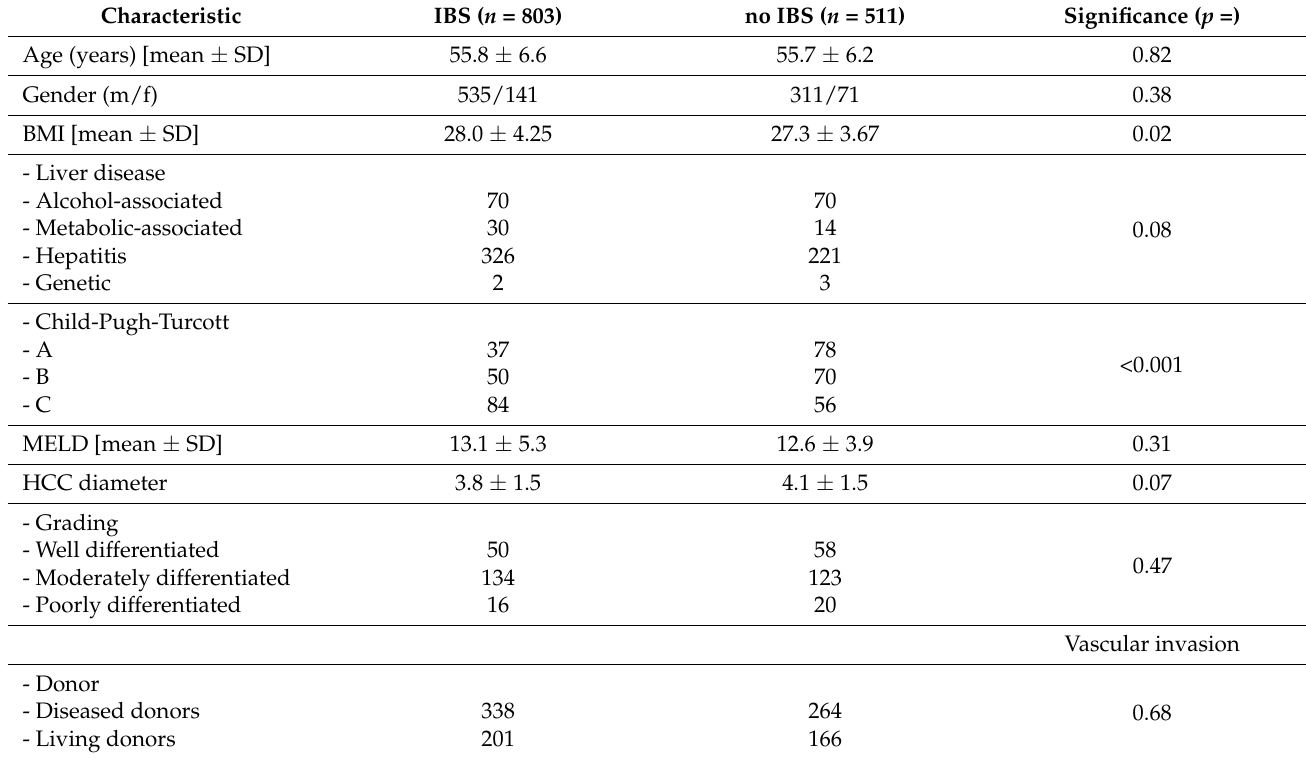
Table 2. Aggregated characteristics summary for liver transplantation patients.